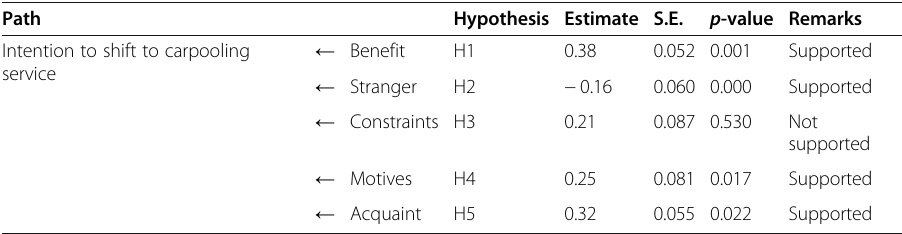
Table 7 Results of structural